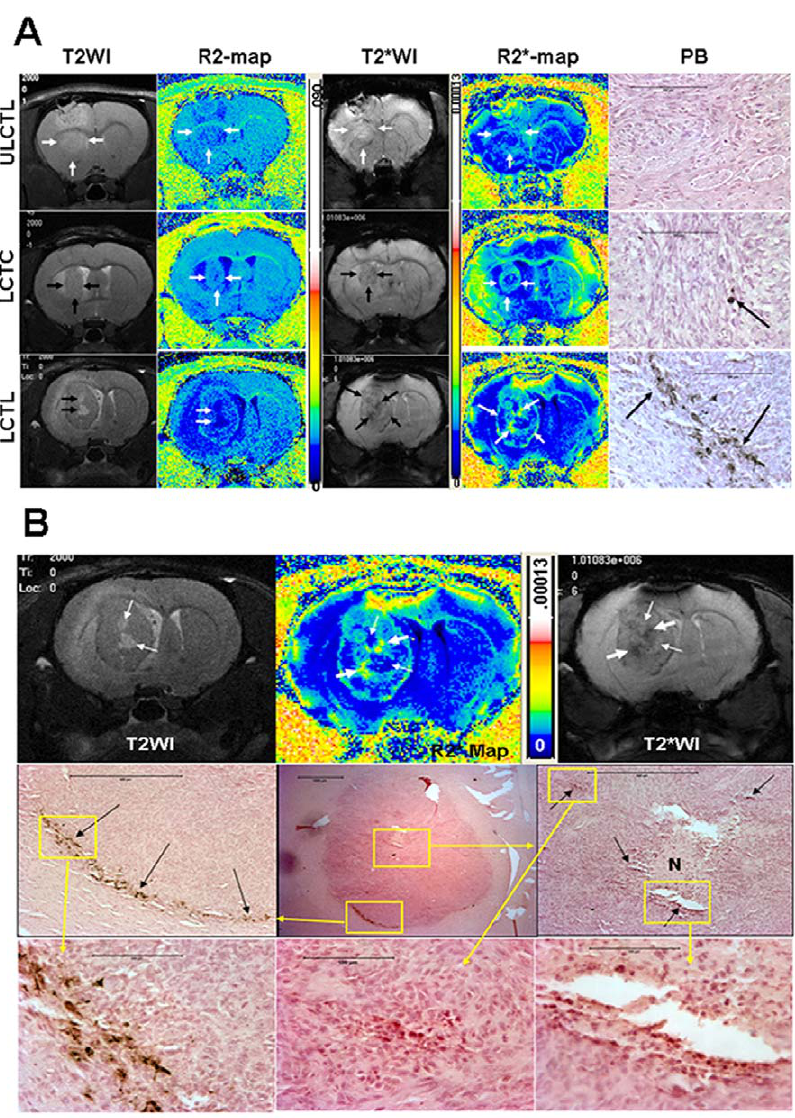
Figure 4. MRI and Prussian blue positive cells in tumors. Figure 4A: T2-weighted and T2*-weighted images and their corresponding R2 and R2* maps and DAB enhanced Prussian blue staining from representative animals that received unlabeled CTL (ULCTL, upper row), labeled control T-cells (LCTC, middlerow)andCTL(LCTL, lowerrow). BothT2WandT2*W images showwellestablishedtumors inthe brain, however, lowsignalintensityareaswereonly seen in tumors that received LCTC and LCTL. Corresponding R2* maps show high signal intensity areas. Animals that received LCTL show high signal intensity areas both at the peripheral and central part of the tumors (arrows). Corresponding DAB enhanced Prussian blues staining show multiple Prussian blue positive cells in tumors that received LCTL (arrows). There are a few Prussian blue positive cells seen in tumor that received LCTC (arrow). No definite Prussianblue positivecells wereseenintumorthatreceivedULCTL. Areas ofnecrosis caneasilybeidentifiedbycomparing T2WIandR2maps (thickarrows) in tumor that received LCTL (lower row). Bars on the images measure 100 m m. Figure 4B: Detailed histological analysis of the tumor that received LCTL. Bars on the images measure 100 m m. Upper panel: T2-weighted image (T2WI) and T2*-weighted image (T2*WI) show areas of necrosis (high signal intensity on T2WI and T2*WI and low signal intensity on R2* map). Thin arrows show the sites of necrosis and thick arrows show possible site of accumulated iron positive cells. Middle panel: Representative histological section with similar tumor orientation (within the constraints of the experimental limitations, i.e. 1 mm thick MRI slices versus 10 m thick histological section) show central necrosis ( N ) in the tumor with areas of iron positive cells (black arrows) seen in the central and peripheral part of the tumor that received iron labeled CTLs. Lower panel: Enlarged view of the boxed areas.